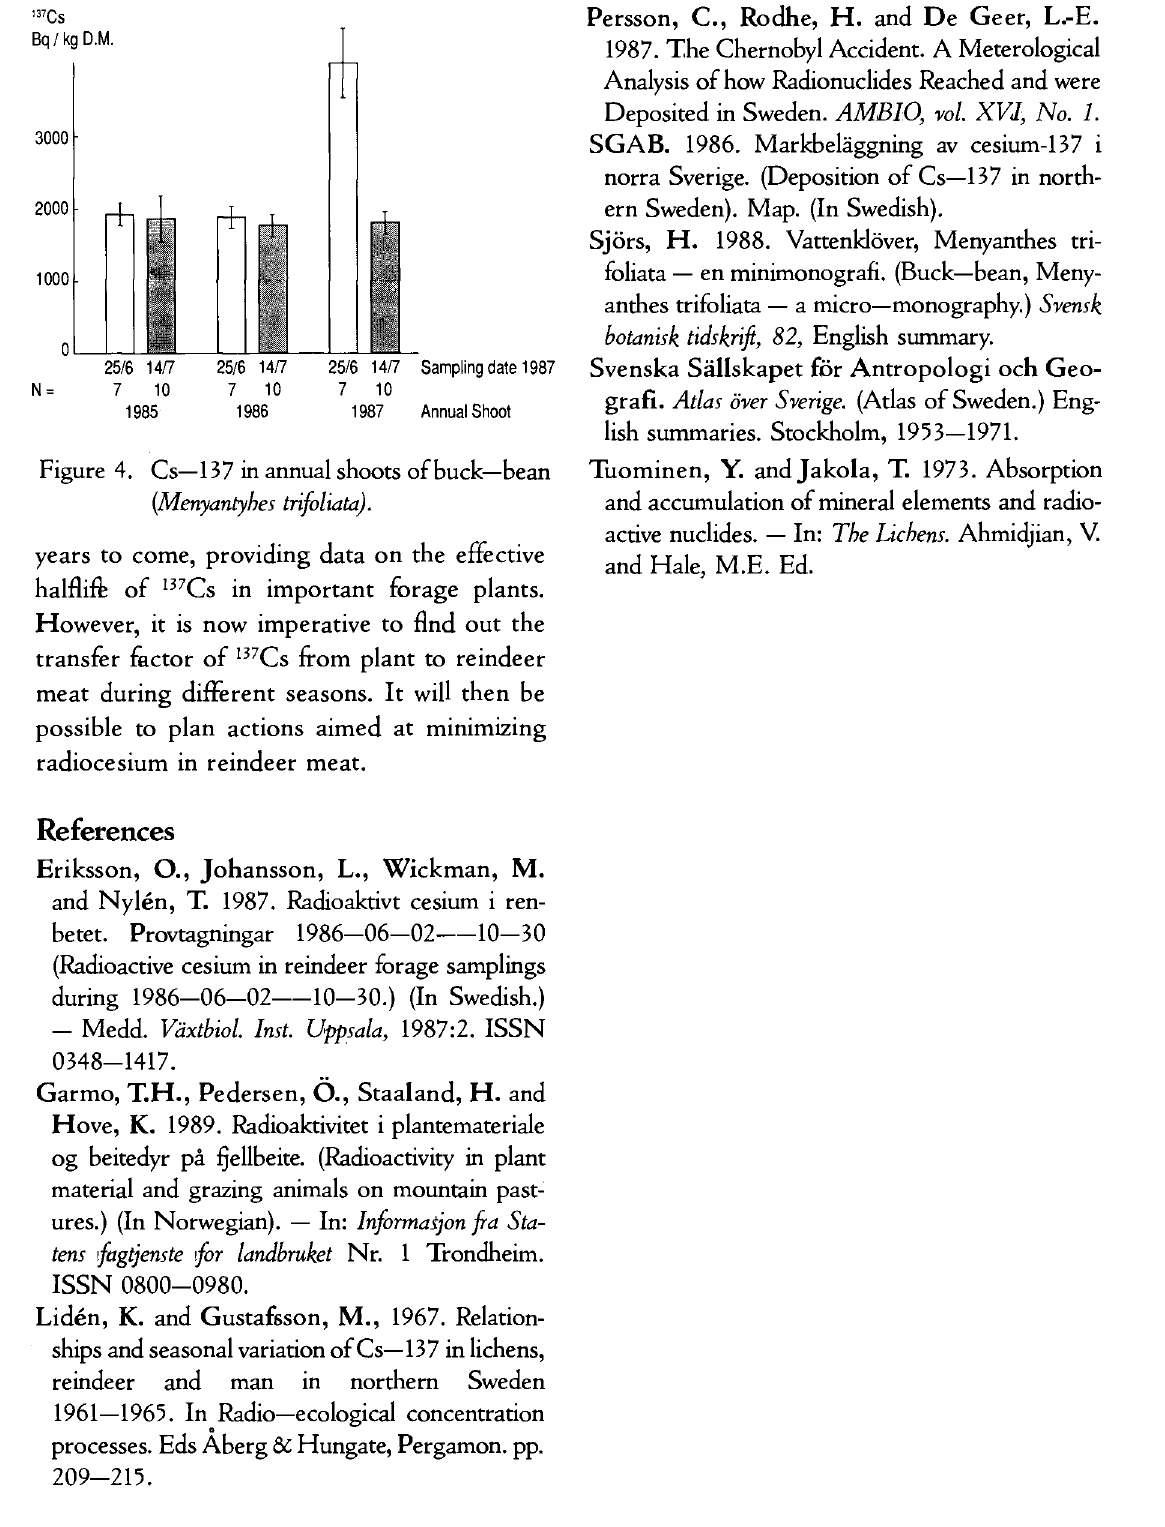
Figure 4. Cs—137 in annual shoots of buck—bean (Menyantyhes